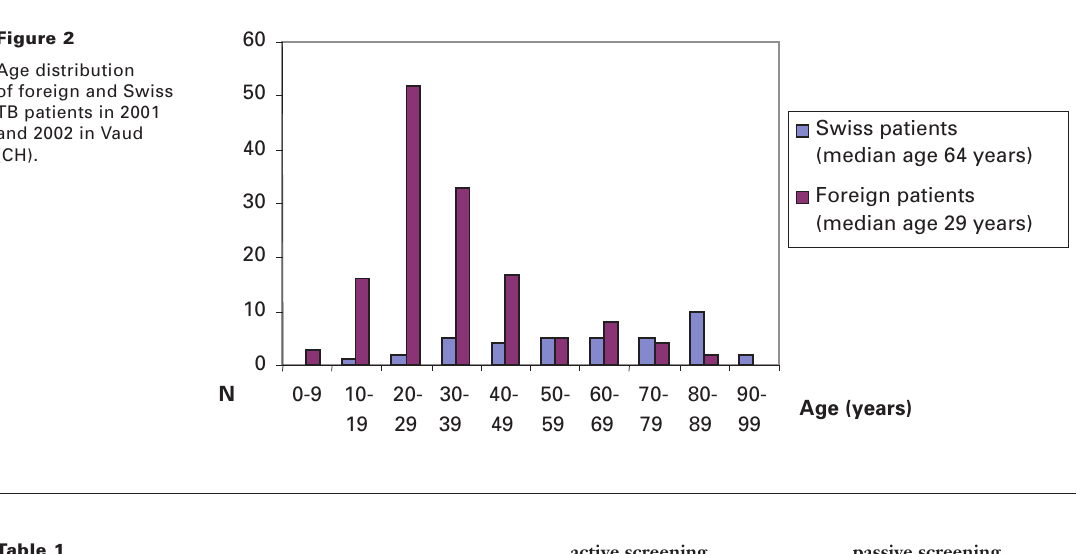
other foreigners (migrants, tourists, students asylum seekers, passively screened after